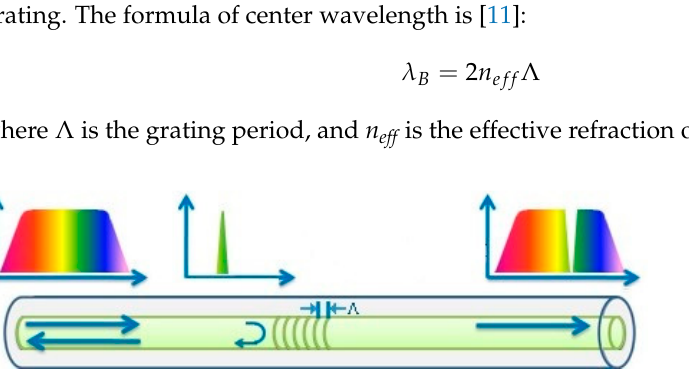
Figure 3. Schematic diagram of fiber grating.